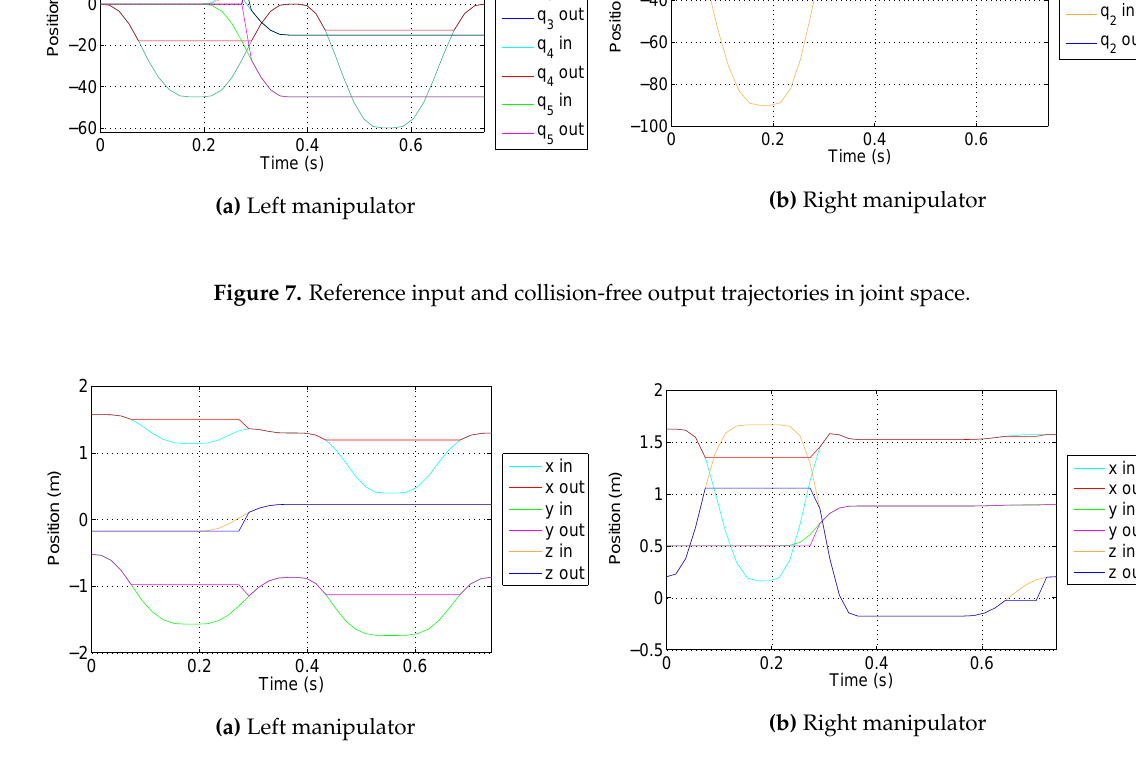
Figure 8. Reference input and collision-free output trajectories in Cartesian